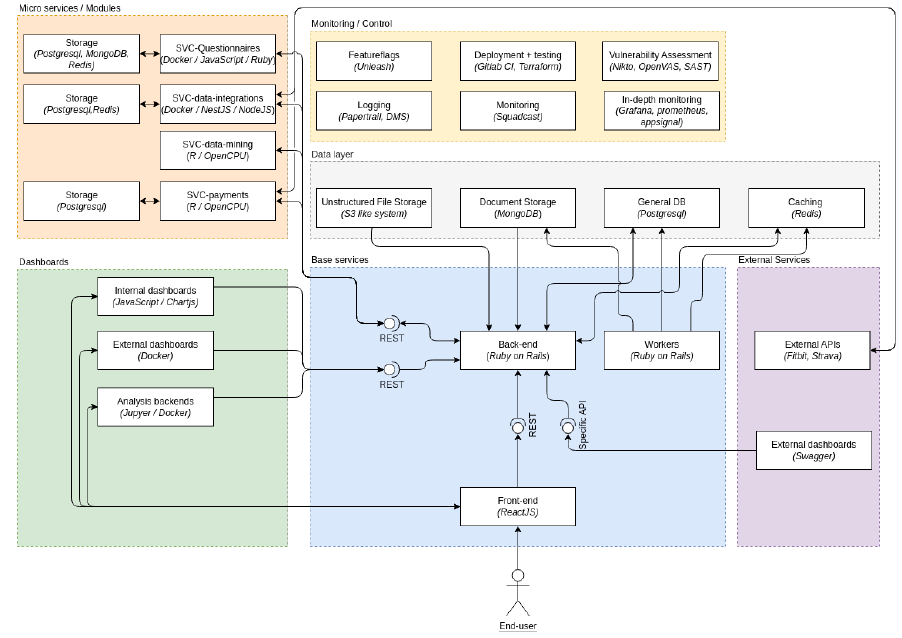
Figure 1. Diagram of the architecture of the platform used for the case